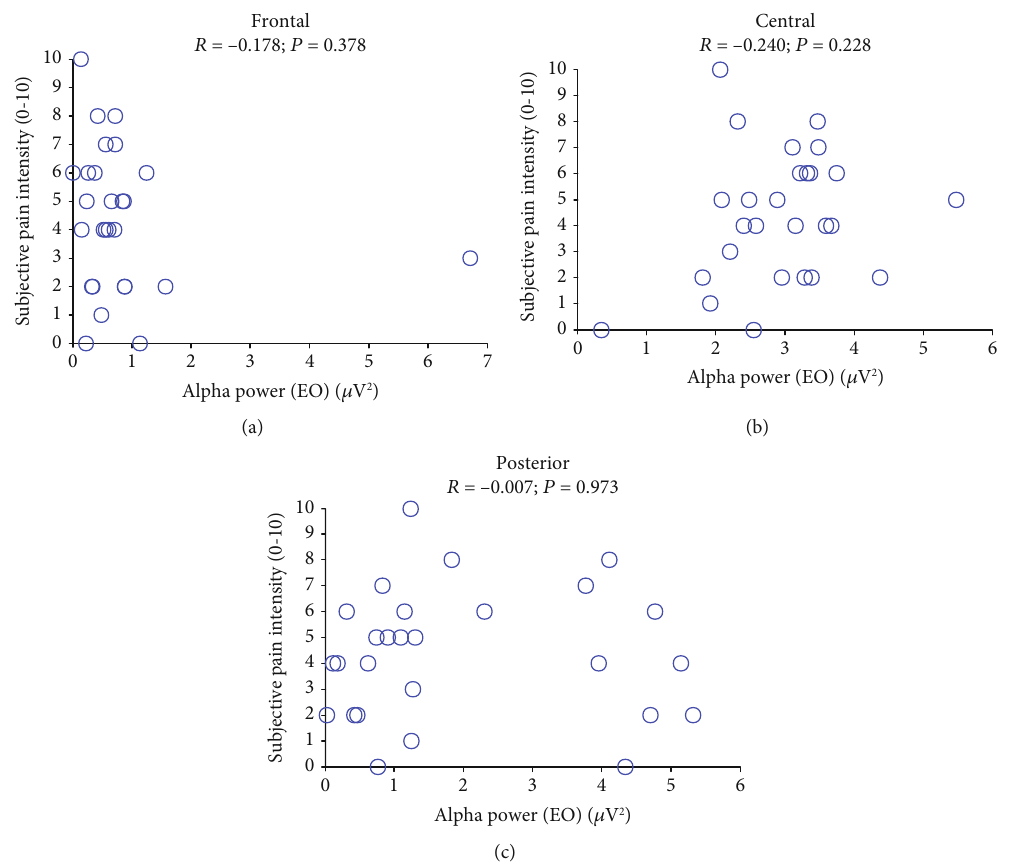
Figure 5: Relationships between alpha power under eyes-open (EO) condition and subjective intensity of pain perception in (a) frontal ( R = − 0 : 178 , P = 0 : 378 ), (b) central ( R = − 0 : 240 , P = 0 : 228 ), and (c) posterior ( R = − 0 : 007 , P = 0 : 973 ) regions.